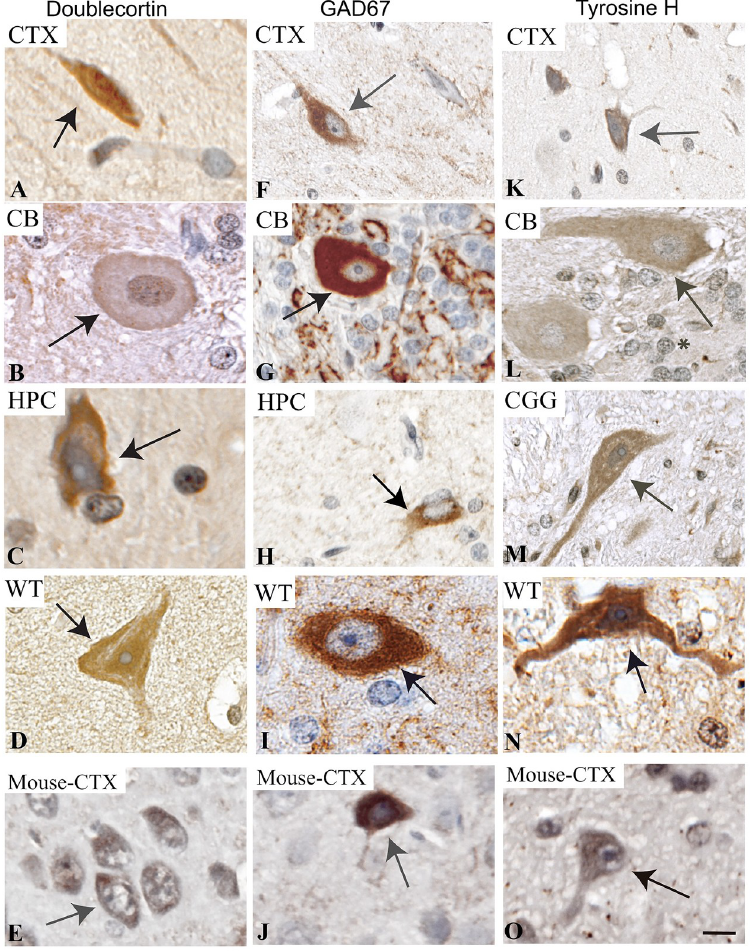
Fig 4. Immunolabeling of neuron markers in the NF1 mutant and wild-type miniswine brain. Brain regions are identified as cortex (CTX), cerebellum (CB), hippocampus (HPC) and cerebral aqueduct (CGG). A-D: Doublecortin + expression in the cortex, cerebellum, hippocampus, and cerebral aqueduct in wild-type miniswine, localized to the cytoplasm of neurons. Arrows indicate immature neurons, with minimal staining in the cerebellum. E: Doublecortin + expression in mouse cerebral cortex. F-I: GAD67+ expression in the cortex, cerebellum, hippocampus, and thalamus in wild-type localized to the cytoplasm of neurons. Arrows indicate GABAergic neuron cell bodies. J: GAD67 + expression in mouse cerebral cortex. K-N: Tyrosine H+ expression in the cortex, cerebellum, and cerebral aqueduct in NF1 and wild-type miniswine, localized to the cytoplasm of neurons. Arrows indicate dopaminergic neurons. O: Tyrosine H+ expression in mouse cerebral cortex. Asterisks indicate lack of immunolabeling. Scale bar: 50 μ m.